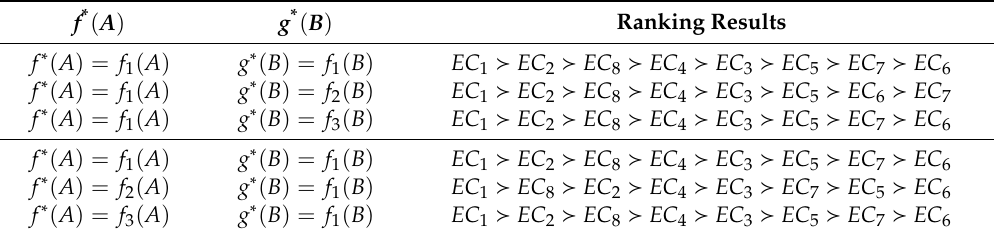
Table 11. Ranking results with di ff erent